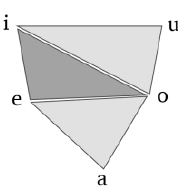
Figure 3. Division of vowel space into three triangles for vowel space area